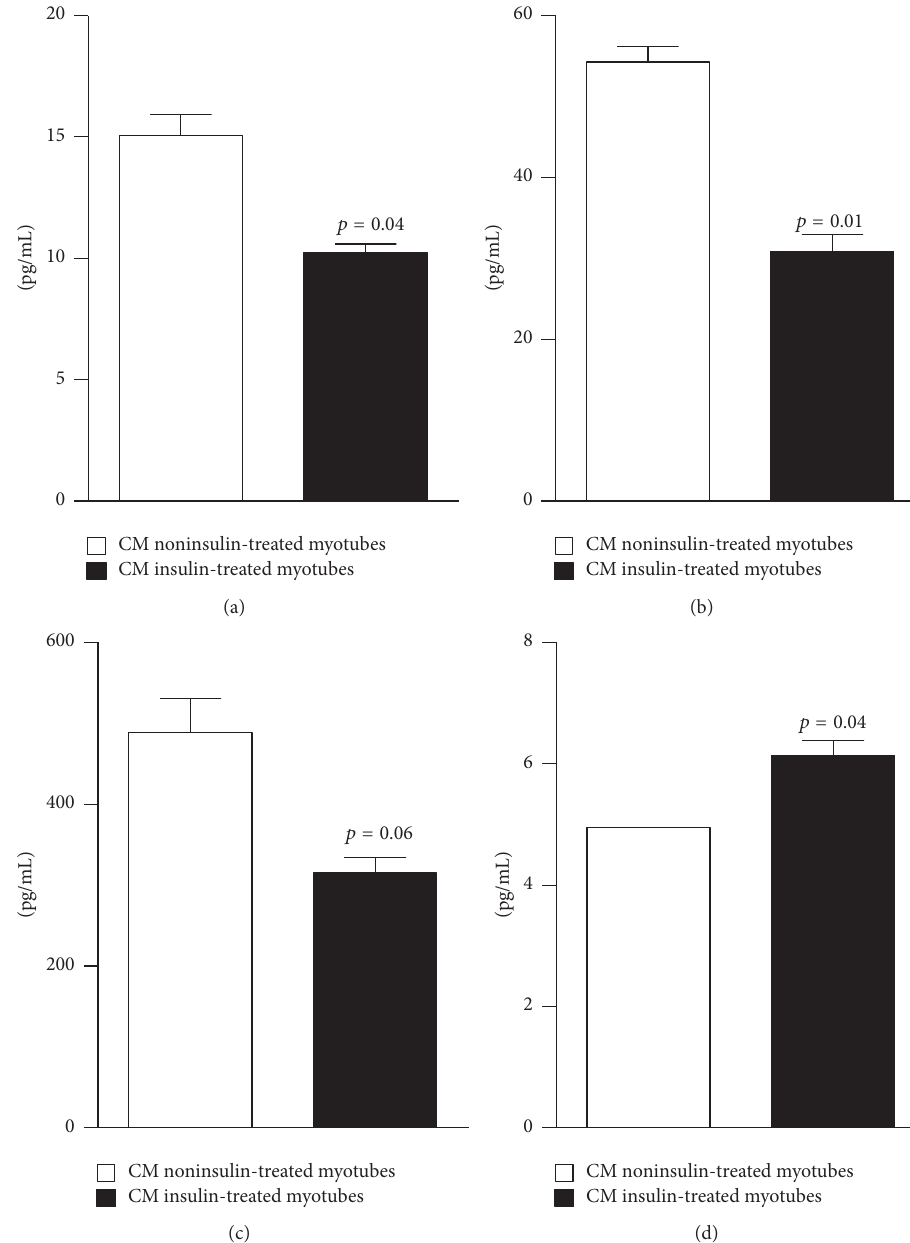
Figure 3: Myokine expression in conditioned media from noninsulin- and insulin-treated myotubes. IL6 (a), IL8/CXCL8 (b), MCP1/CCL2 (c), and RANTES/CCL5 (d) determined by multiplex in myotube-conditioned media from noninsulin- and insulin-treated myotubes. Mean ± SEM. Analysis by two-tailed t